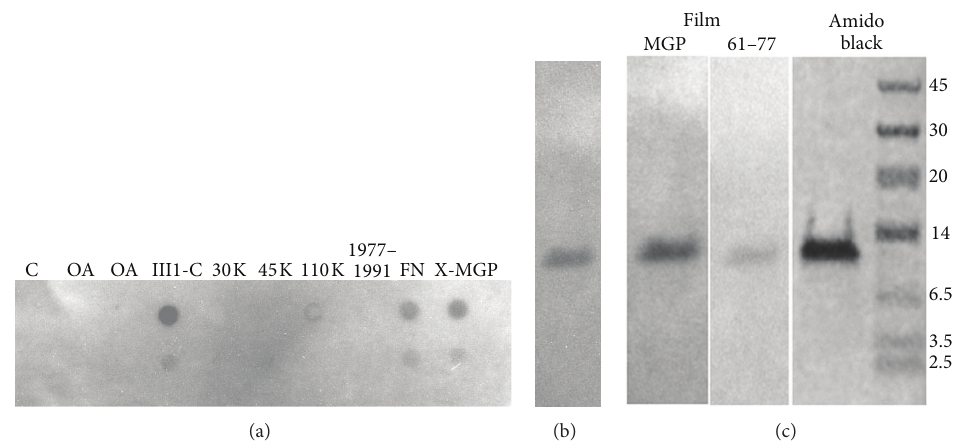
Figure 1: MGP binds to fibronectin and to the first type III repeat domain of fibronectin III1-C. (a) MGP binds fibronectin and fibronectin fragments with type III repeats. Dot blot spots with radioactive MGP probe and 100 microliters of protein solutions were dot blotted onto the nitrocellulose filter, then blocked with 1% BSA-PBS, overlaid with radioactive MGP, washed, and exposed to film as described in methods. C, PBS buffer; OA, 1mg/mL ovalbumin; FNIII1C, 1mg/mL fibronectin III1-C; 30KFN, 1mg/mL 30 kDA fragment of fibronectin; 45 KFN, 1mg/mL 45 kDA fragment of fibronectin; 110KFN, 1 mg/mL 110 kDA fragment of fibronectin; 1991–1997, 1mg/mL of the cell binding peptide of fibronectin comprised of amino acids 1991 through 1997; FN, 1mg/mL fibronectin; anti-MGP, 5 𝜇 g/mL of anti-MGP IgG from rabbit. The lower row of dot blotted proteins contains 10x lower concentration of proteins. (b) Radioactive MGP probe binds to fibronectin III1-C on far western blot. Fibronectin III1-C is run on SDS-PAGE, electroblotted, blocked and overlaid with iodinated MGP, washed, and exposed to film as described in methods. (c) Both MGP and the 61–77 C-terminal peptide of MGP bind to fibronectin III1-C. Far western blot with either 125 I-MGP or 125 I-MGP 61 – 77 overlay on fibronectin III1-C and exposed to film as described. Both probes bind to a band that comigrates with a gel band of fibronectin III1-C shown stained with amido black next to molecular weight